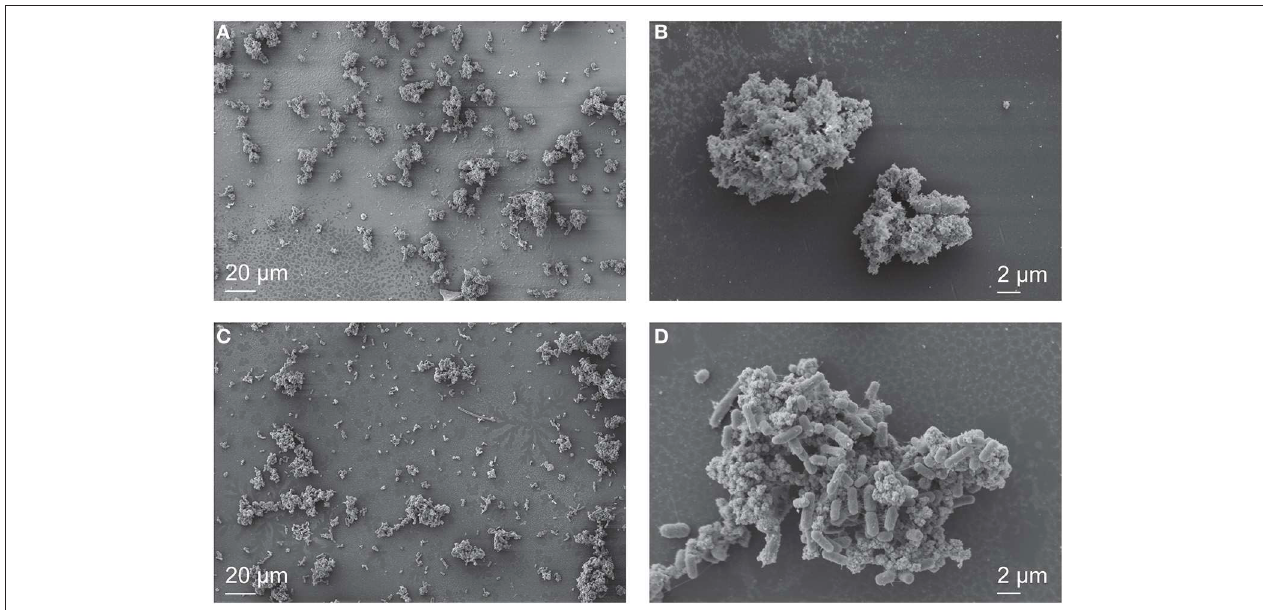
FIGURE 4 | SEM images of Synechococcus PCC 7002 cultured anoxically in 4500 µ M Fe(II)-containing medium. In the early stages of growth, when 4000 µ M Fe(II) remained in solution, individual cells are difficult to locate (A) , and the sample is predominantly composed of Fe minerals that surround the cells (B) . When nearly all the Fe(II) is oxidized (300 µ M remains), cells are abundant (C), and cell surfaces are nearly free of Fe minerals (D) .